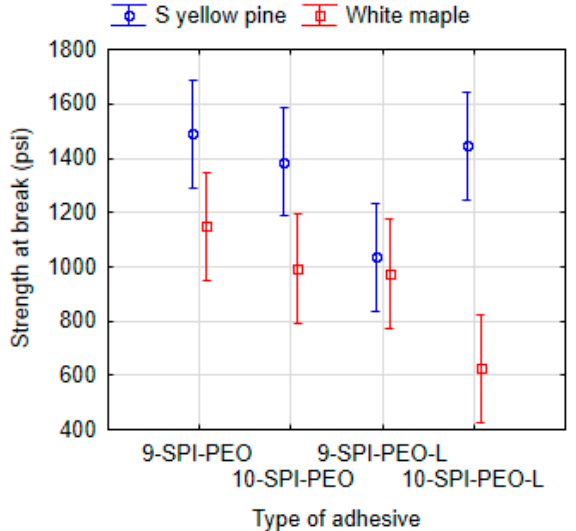
Figure 7. ANOVA of the dry shear strength at the break point and the effect between 9% and 10% total solid on the adhesives with SPI, PEO and lignin variation. Vertical bars denote 95% confidence interval.